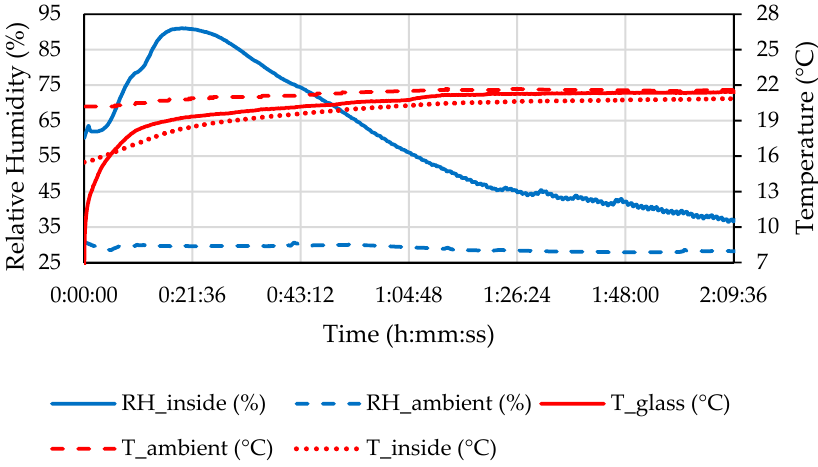
Figure 12. Temperature and relative humidity of the ambient air, air inside the headlamp, and temperature of the front glass during the C1.5 defogging phase.